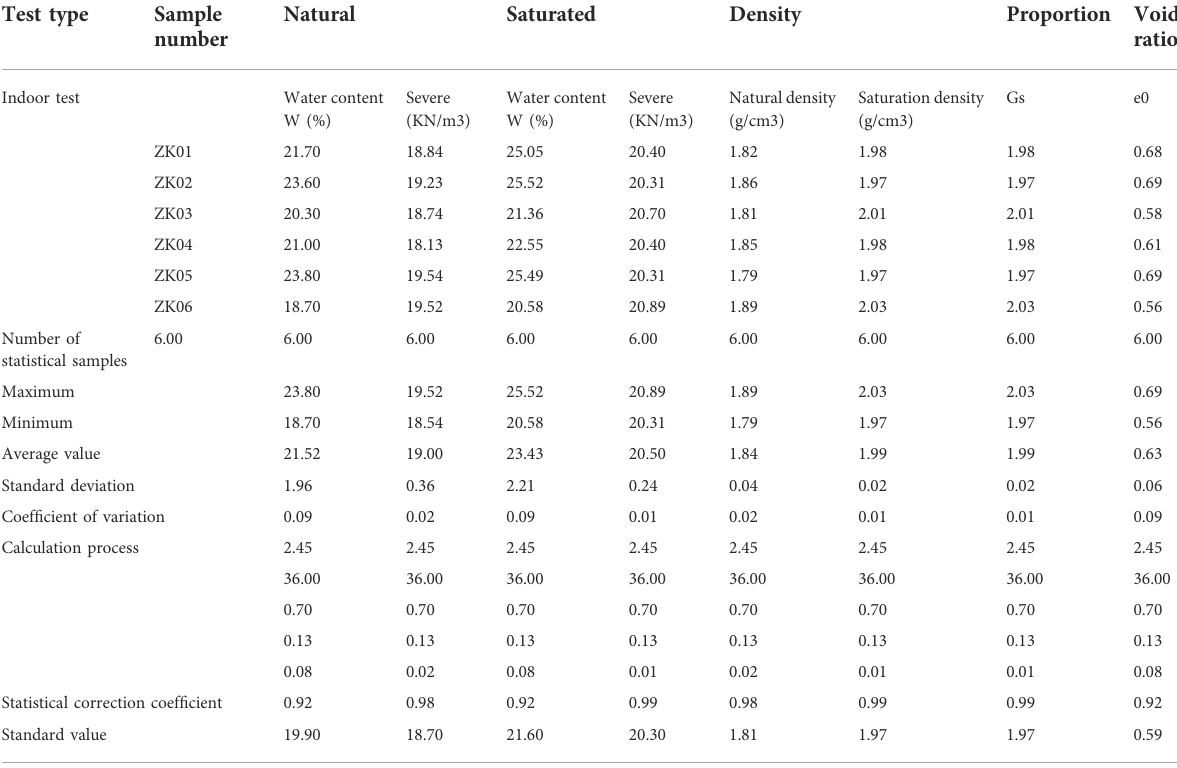
TABLE 2 Statistical table of physical and mechanical parameters of landslide